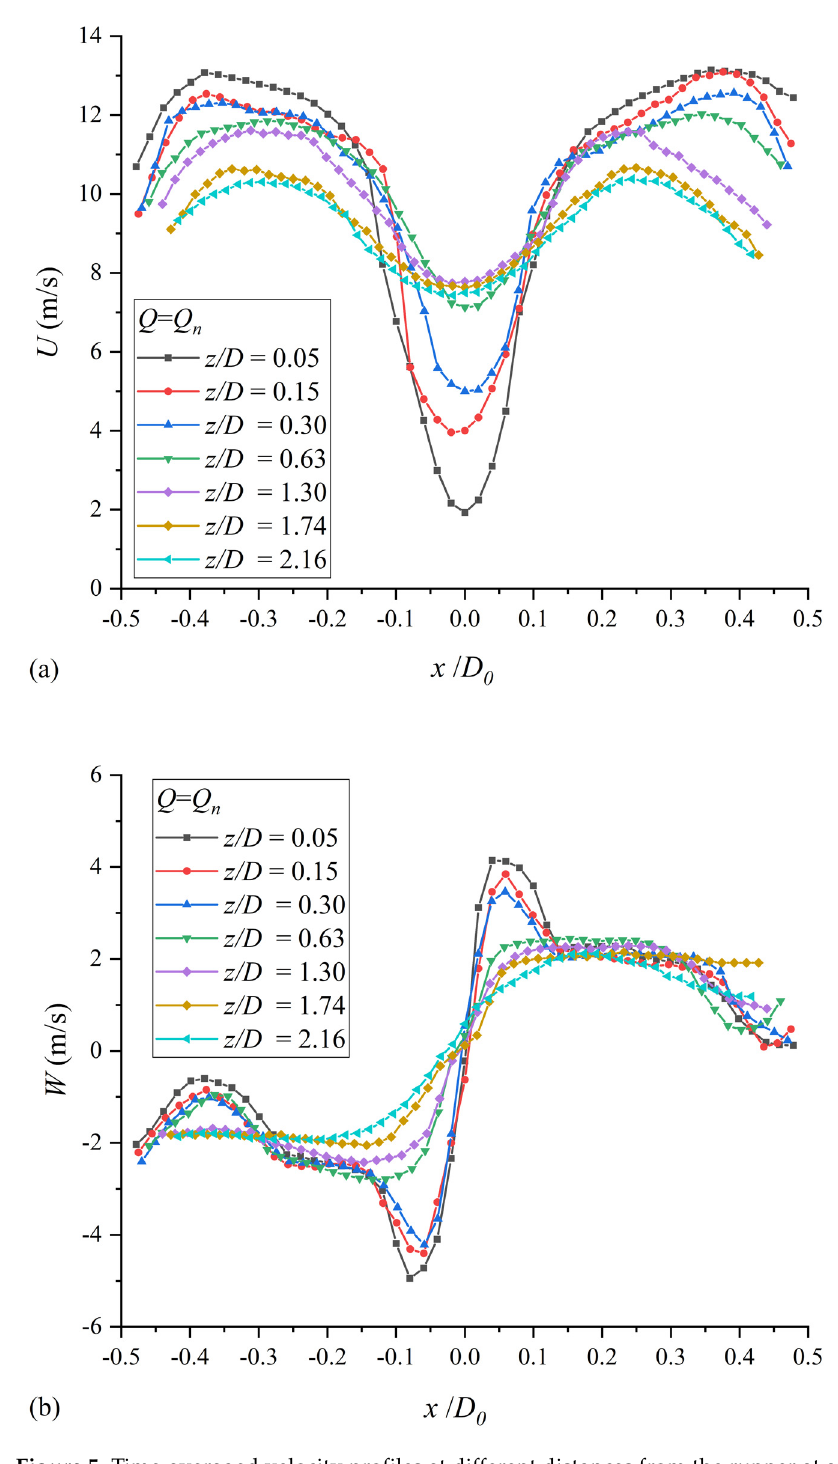
Figure 5. Time-averaged velocity profiles at different distances from the runner at a constant runner speed ω n : ( a ) Axial component; ( b ) Tangential component. Operating regime with Q = Q n . At z / D = 1.30, S = 0.1.